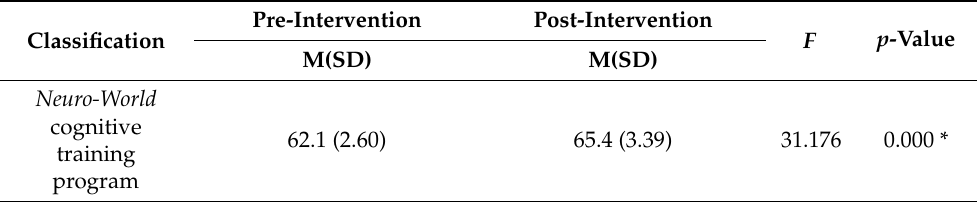
Table 5. Differences between pre- and post-intervention of experimental